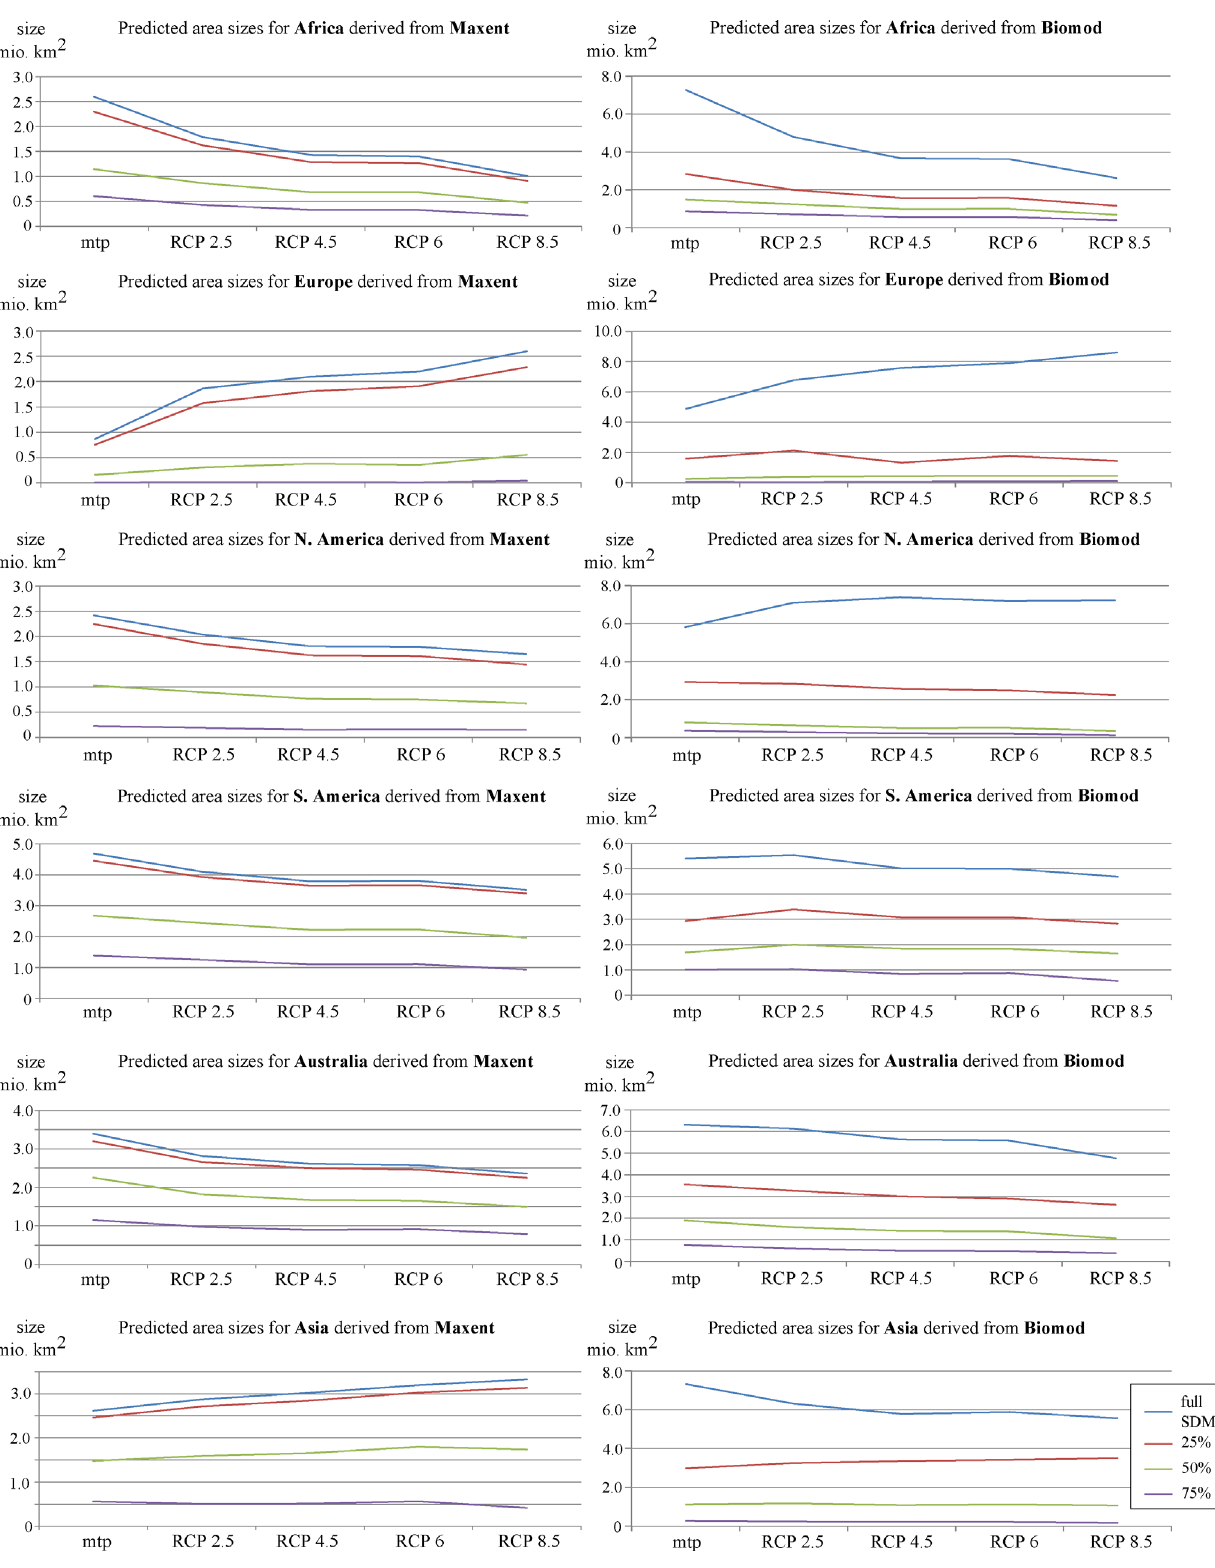
Fig 5. Predicted development of area sizes suitable for X . laevis on a continental scale; left) for the Maximum entropy SDM, right) for the ensemble SDM. Mtp = minimum training presence, all areas sizes refer to SDM area – MESS area. doi:10.1371/journal.pone.0154869.g005 PLOS ONE | DOI:10.1371/journal.pone.0154869 June 1,